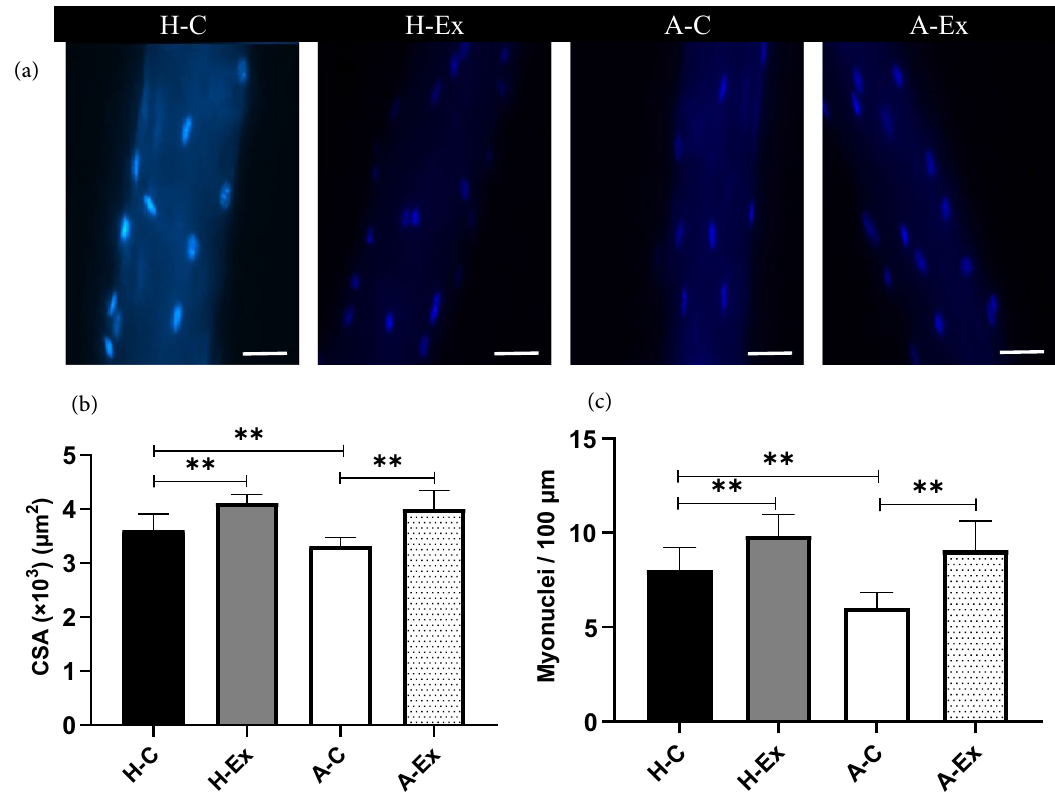
Figure 4. Morphometric analysis of myonuclei in gastrocnemius isolated myofibers in different experimental groups. ( a ) Representative image of nuclei stained by DAPI in isolated myofiber (Scale bar = 20 µm). ( b ) Quantification of CSA (× 10 3 ) (µm 2 ). ( c ) Number of myonuclei for 100 µm of isolated fibers. ** p <